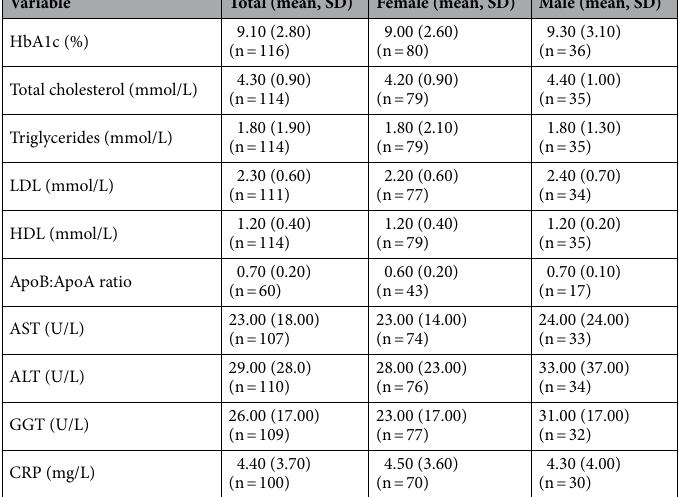
Table 2. Biomarkers of metabolic health in study participants. HbA1c hemoglobin A1c, LDL low-density lipoprotein, HDL high-density lipoprotein, ApoB apolipoprotein B, ApoA apolipoprotein A, AST